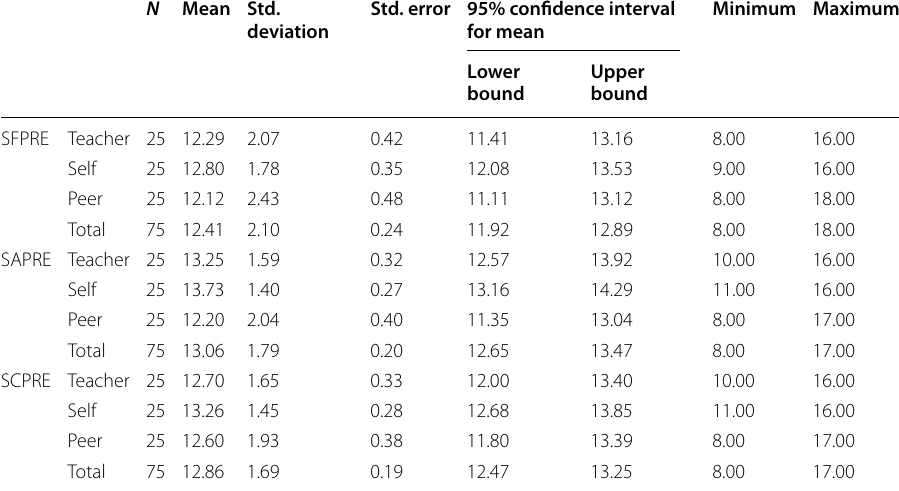
Table 1 Descriptive statistics of all groups on the pretests of speaking accuracy, fluency, and complexity N Mean Std. Std. error 95% confidence interval deviation for